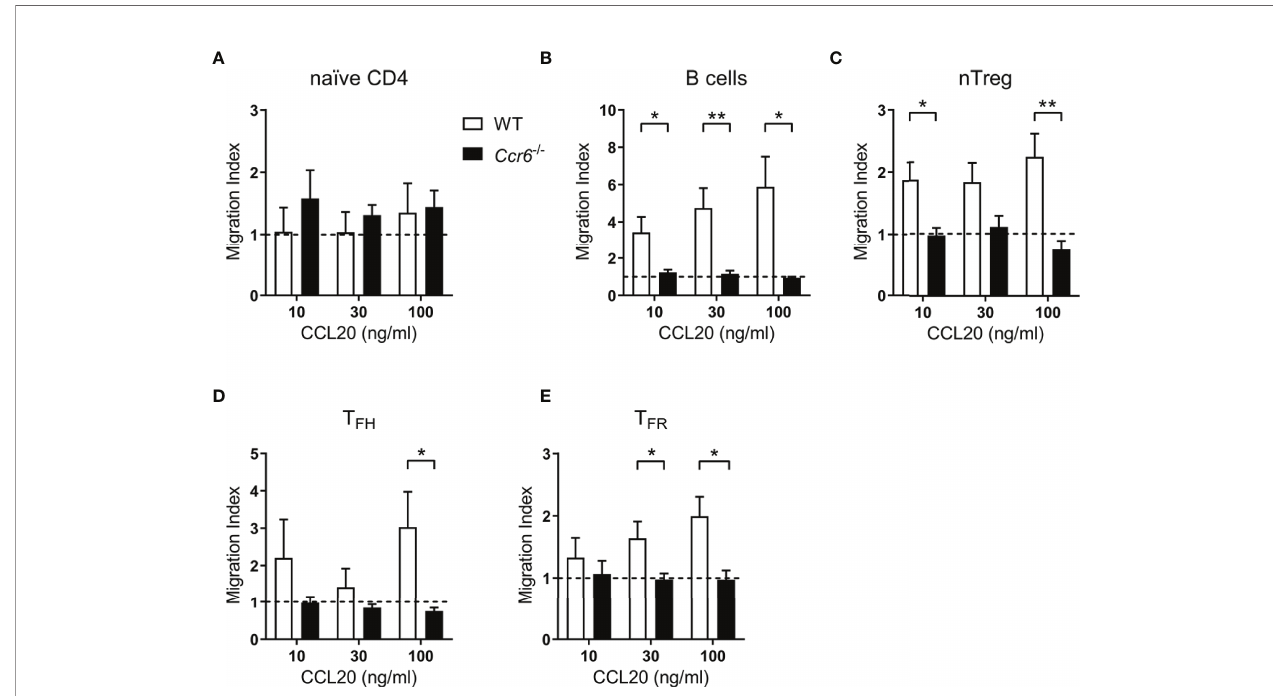
FIGURE 3 | Follicular T cell populations migrate ex vivo to CCL20. (A – E) Transwell migration of splenocytes from day 6 SRBC immunized WT or Ccr6 -/- mice to increasing concentrations of CCL20. Cell populations were identi fi ed within total migrated splenocytes by fl ow cytometry and migration index was calculated